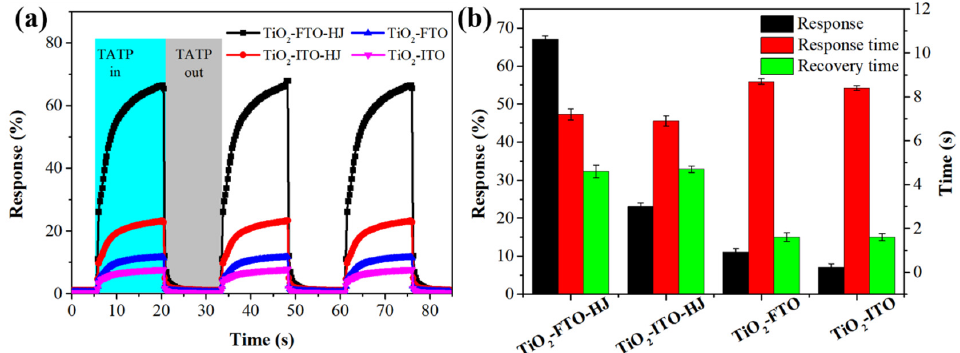
Figure 10. Gas sensing performance diagram of explosives of TiO 2 nanoarrays ( a ) and the corresponding statistical chart of response, response time and recovery time ( b ).